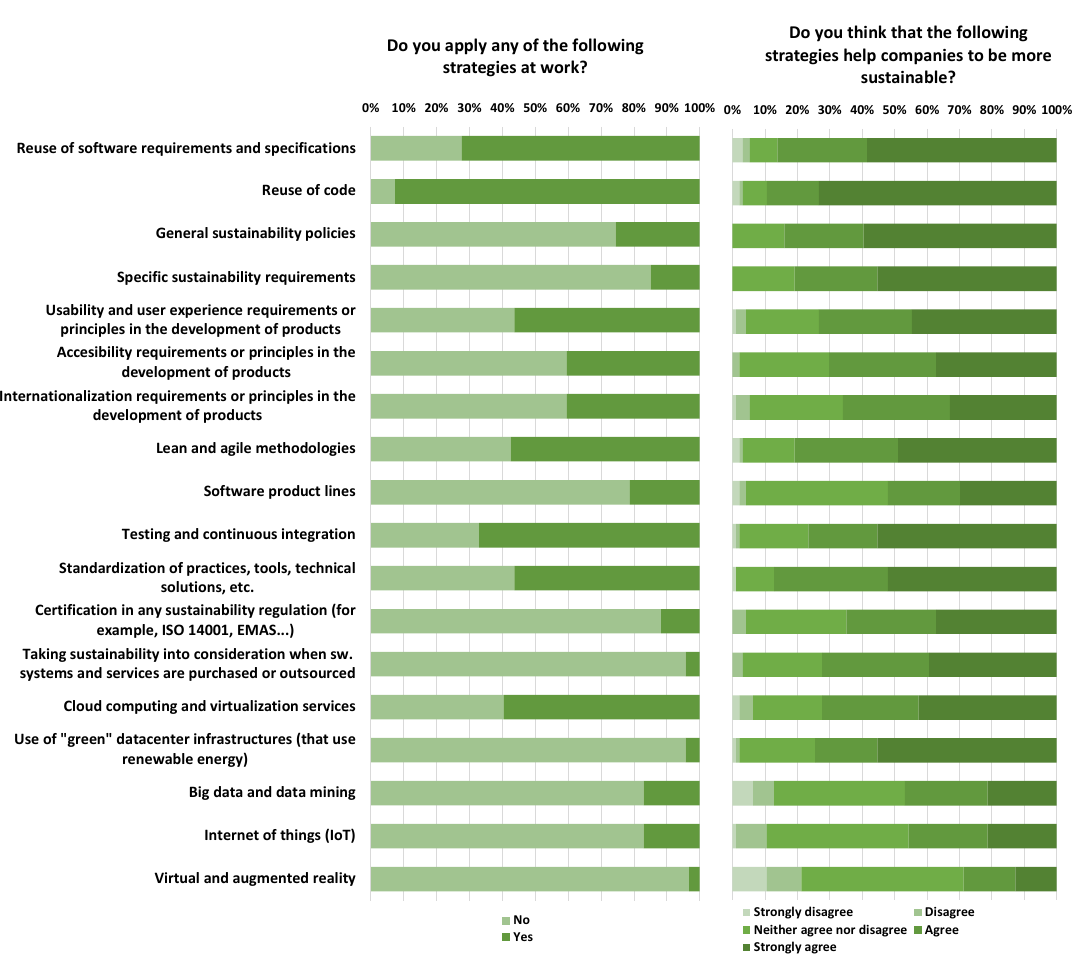
Figure 2. Comparison of results. Application of technical practices vs. the perceived helpfulness of technical practices in being more sustainable at work.